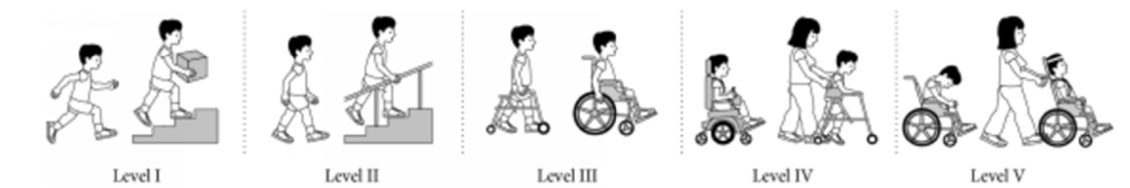
Figure 1. Global Motor Function Classification System (GMFCS).